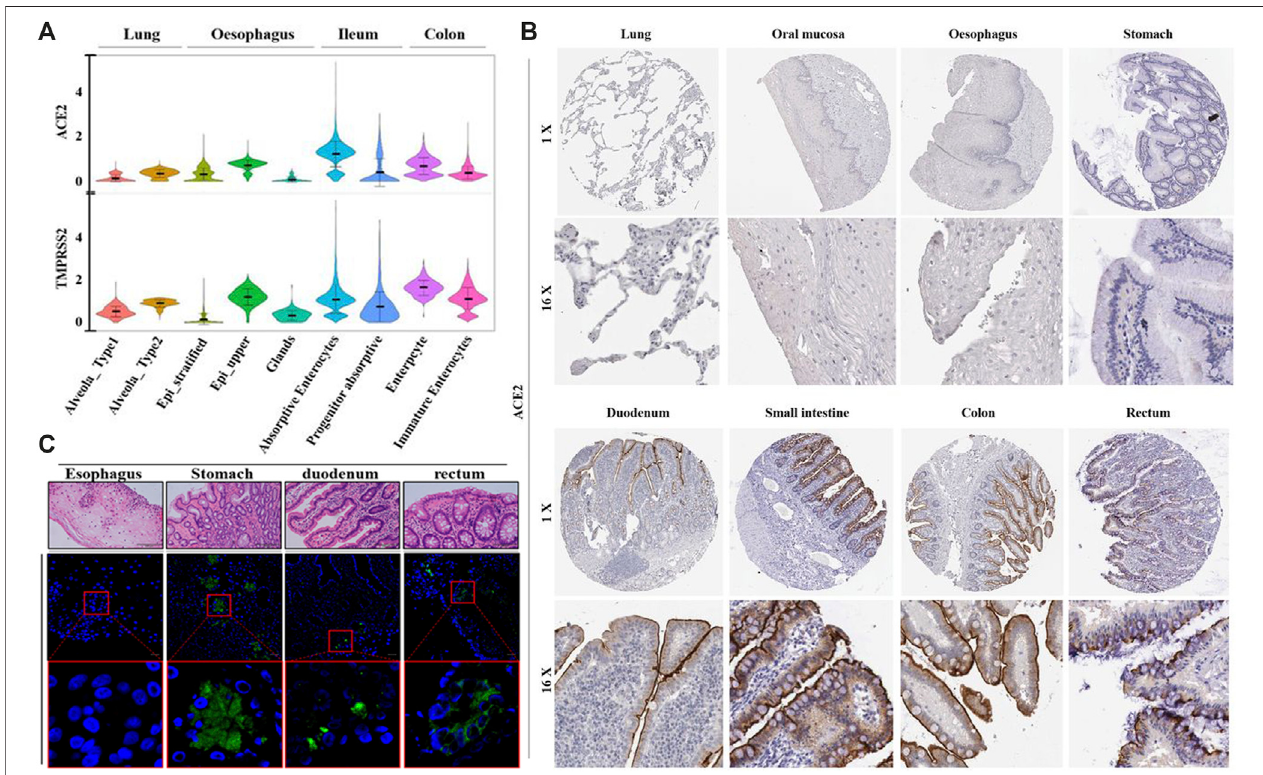
FIGURE 2 | The abundance of ACE2, transmembrane serine protease (TMPRSS2) and tissue tropism of SARS-CoV-2 infection. (A) Violin plots for the levels of ACE2 and TMPRSS2 expression across various cell types among different tissues from healthy donors. (B) The distribution of ACE2 protein in the respiratory and digestive tracts from healthy individuals, by immunohistochemical imaging. (C) Images of gastrointestinal tissues from COVID-19 patients with immuno fl uorescent staining of SARS-CoV-2 NP. Reproduced with permission (Xiao et al., 2020; Zhang H. et al., 2020). Copyright 2020, the British Medical Journal and American Gastroenterological